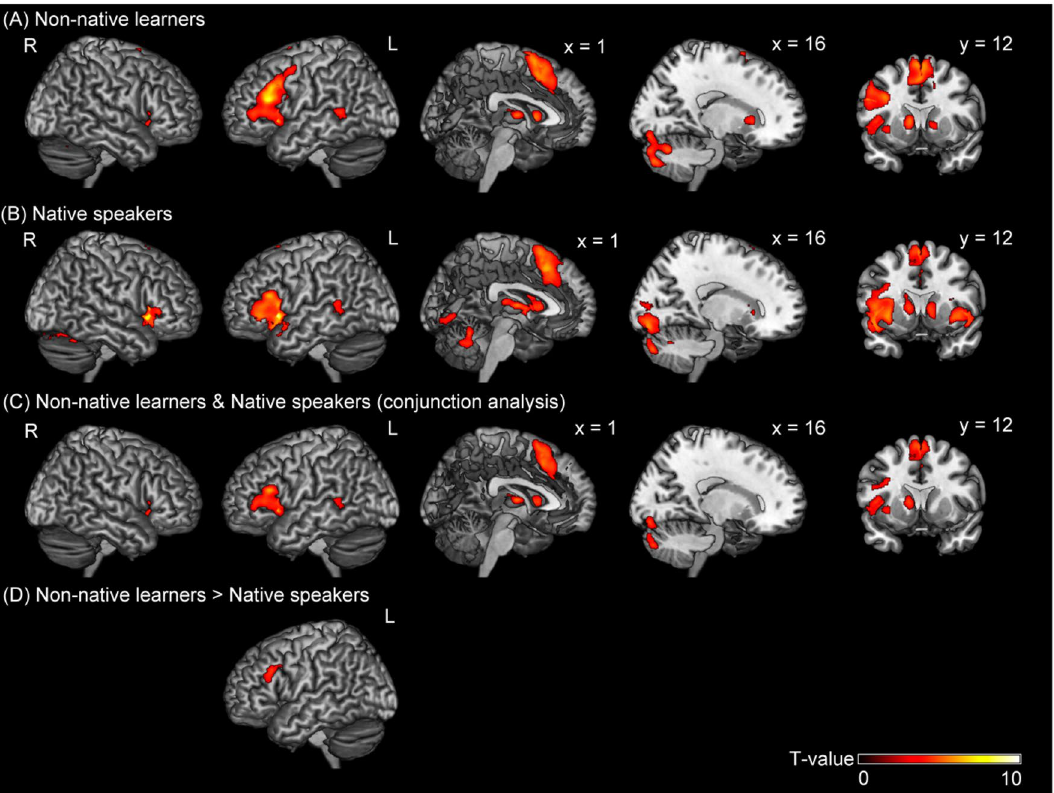
Figure 3. Regions associated with correct grammar processing. Brain activation was associated with grammar processing (grammar > letter) in ( A ) non-native learners, ( B ) native speakers, ( C ) the conjunction of non-native learners and native speakers, ( D ) non-native learners greater than native speakers, and ( E ) native speakers greater than non-native learners. The level of activation was set at a threshold p -value of < 0.05 and the FWE was corrected for multiple comparisons over the whole brain, with the height threshold set at a p -value of < 0.001